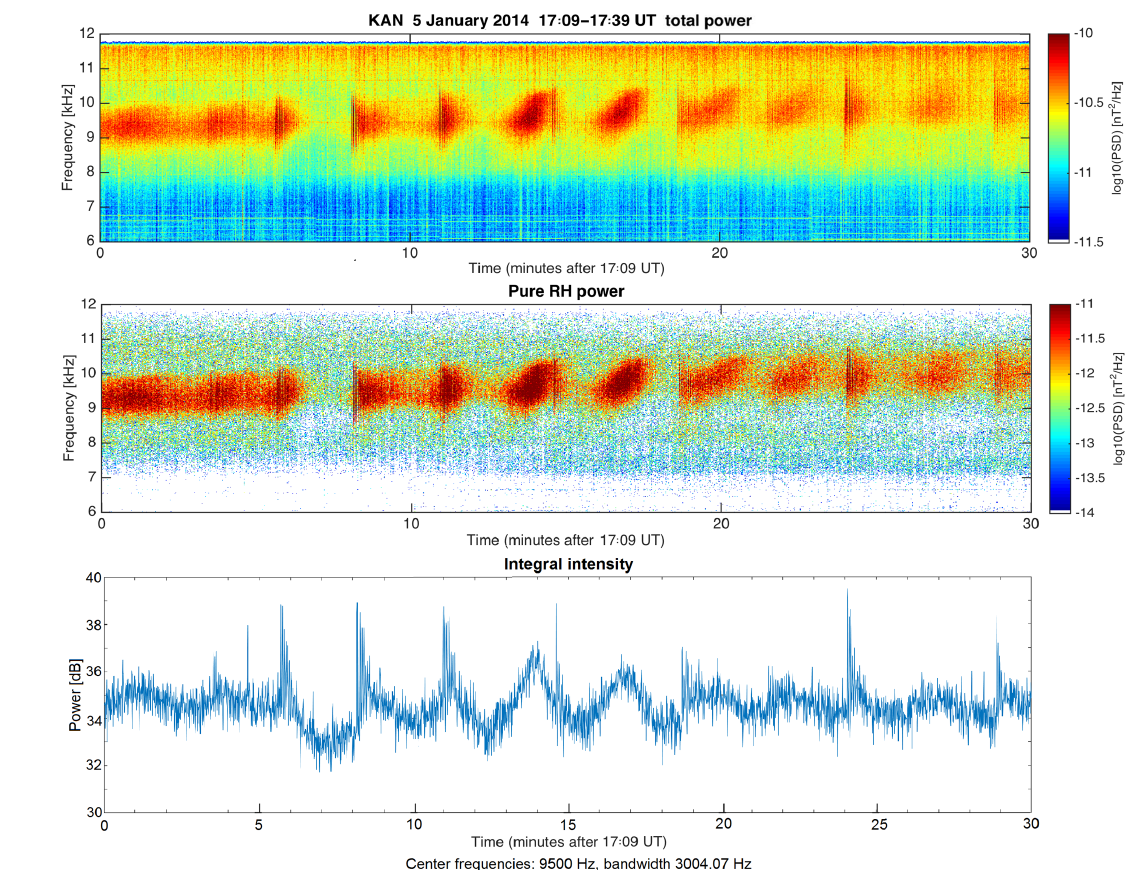
Figure 4. The 6–12kHz VLF spectrograms (total and right-handed powers) and the variation of the integrated wave intensity in the 8–11kHz frequency band on 5 January